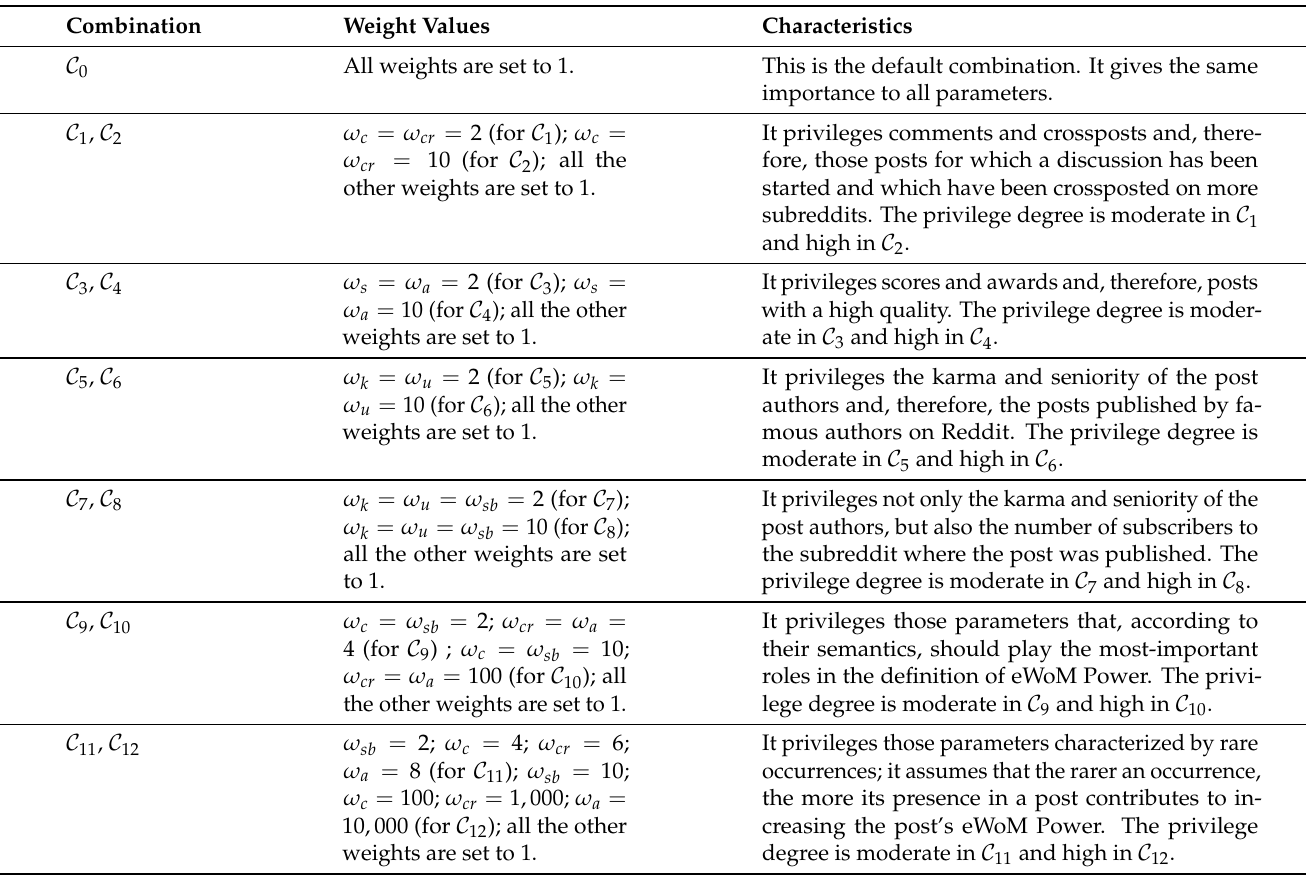
Table 5. Our proposals of weight